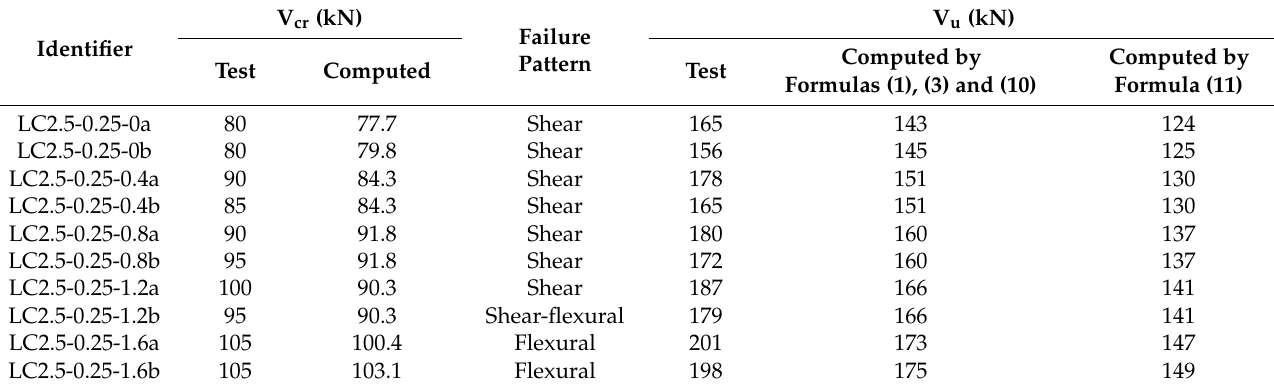
Figure 5. Shear crack widths of test beams at different loading levels. Table 2. Test and calculation results of shear-cracking force, shear capacity, and failure mode.